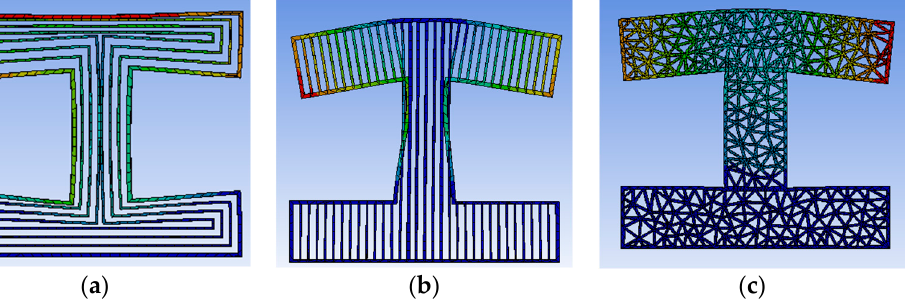
Figure 8. Finite element simulation diagram. ( a ) Contour offset filling; ( b ) straight lines filling; ( c ) Delaunay triangulation filling.